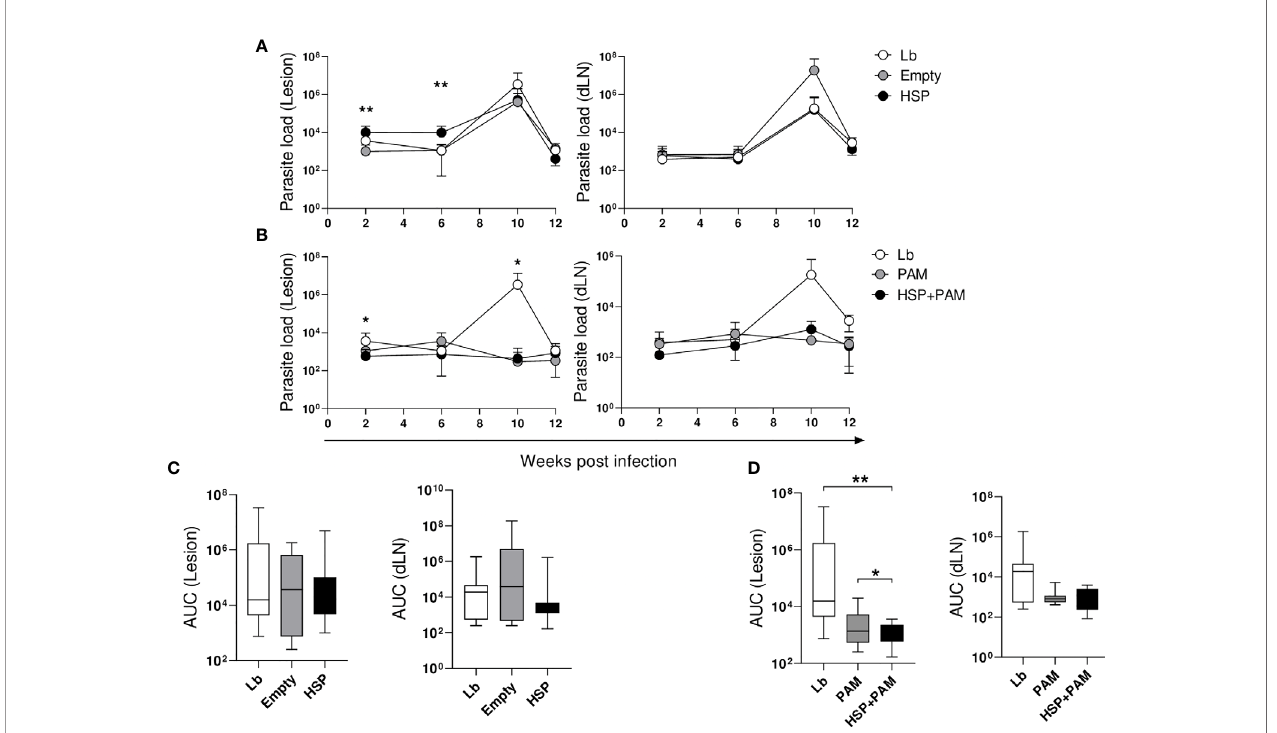
FIGURE 2 | Kinetics of parasite load. Mice were treated with water (Lb and PAM), GM17 Medium with empty vector-bearing L. lactis (Empty) or XM17 medium containing Hsp65-producing L. lactis (HSP and HSP+PAM) for 4 consecutive days, then inoculated with L. braziliensis metacyclic promastigotes in the ear 10 days later. Two days prior to infection, the HSP+PAM and PAM groups received an intraperitoneal administration of PAM3CSK4. After euthanizing animals at 2, 6, 10 and 12 weeks post-infection, ears and draining lymph nodes were collected, cultured and parasite loads were then individually determined by limiting dilution assay. (A) Lb, Empty and HSP groups, (B) Lb, HSP+PAM and PAM groups, (C) area under the curve of Lb, Empty and HSP groups, (D) area under the curve of Lb, HSP+PAM and PAM groups. The area under the curve was constructed using parasite load data from each group. (A, B) Parasite numbers are represented as the means ± SD. (C, D) Parasite numbers are represented as medians and interquartile range. Data are representative of four independent experiments involving 10 animals per group. For nonparametric data, Kruskal-Wallis with Dunn ’ s post-test was used; (*) indicates P < 0.05 (between Lb and HSP groups at 6 weeks in (A) , Lb and HSP+PAM groups at 2 and 10 weeks in (B) and (**) P < 0.001 [between Empty and HSP groups at 2 and 6 weeks in (A)